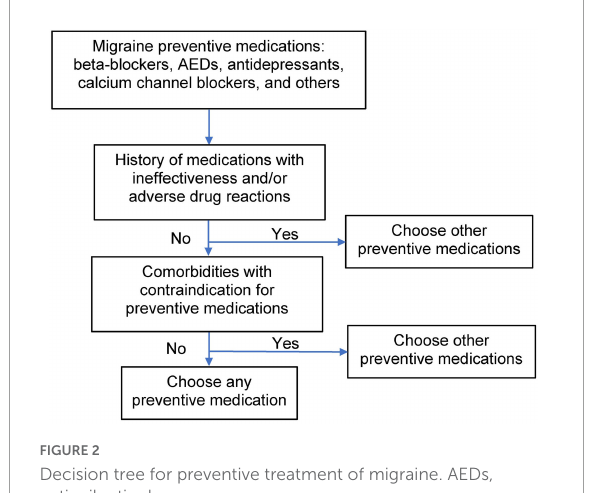
FIGURE2 Decision tree for preventive treatment of migraine. AEDs, antiepileptic